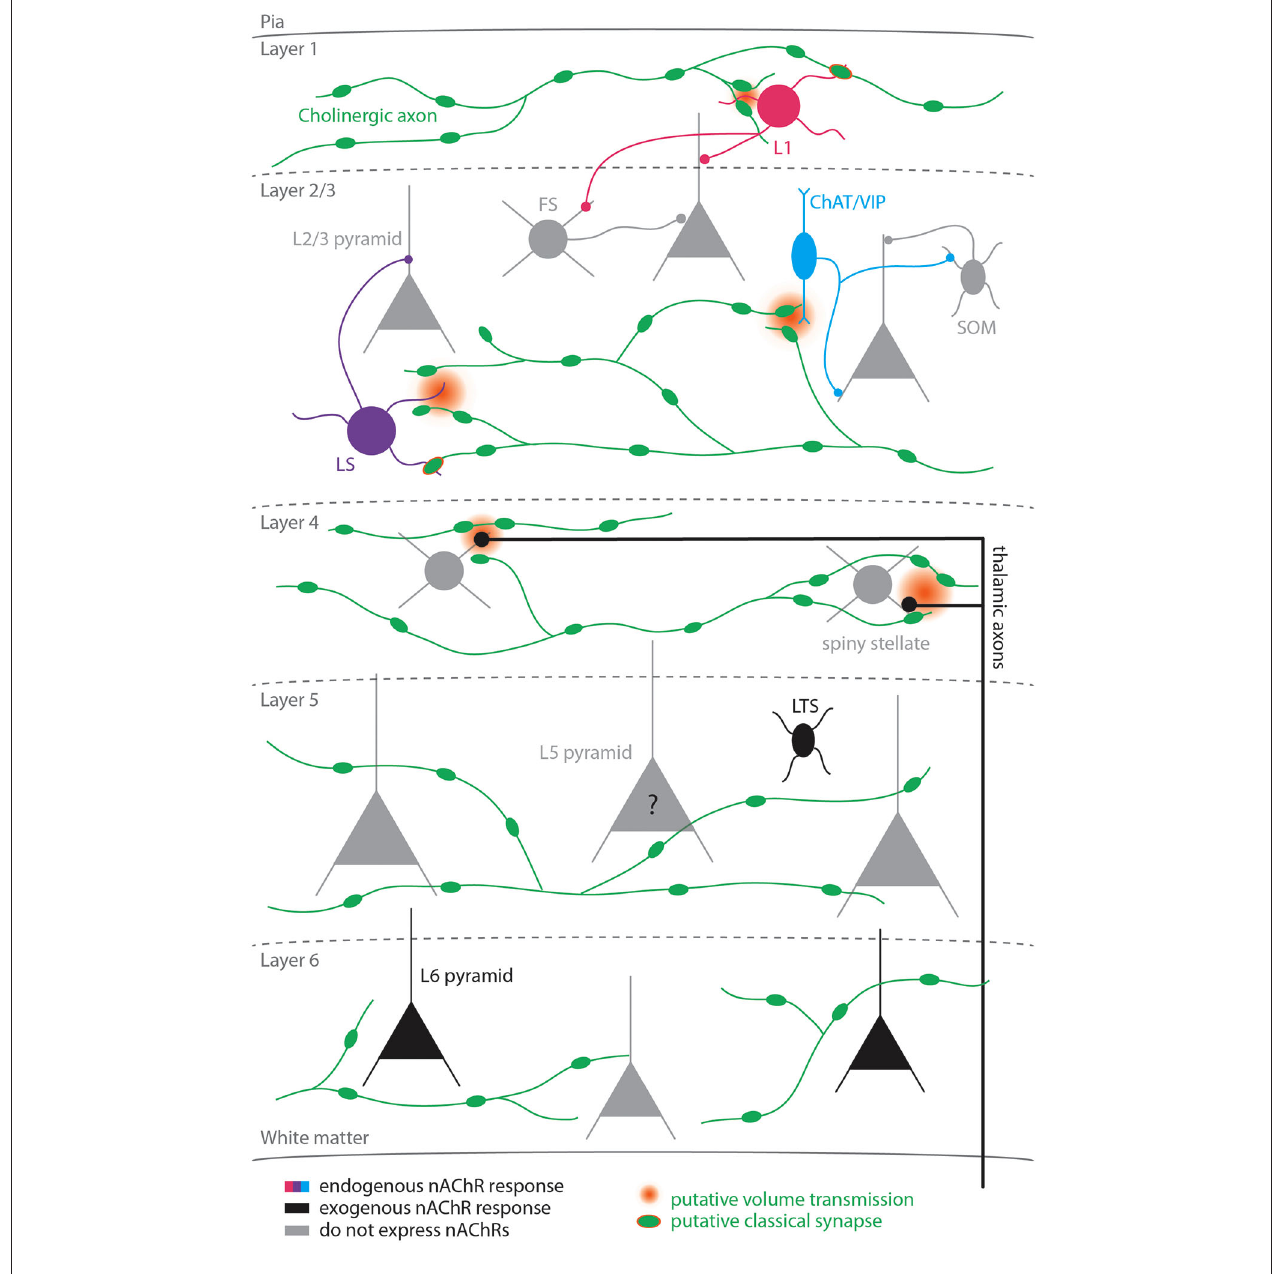
mark for L5 pyramidal cells reflects the fact that studies disagree as to whether this cell-type expresses functional nicotinic receptors. Two types of nicotinic signaling are depicted: putative volume transmission targeting non- α 7 nAChRs (gradient) and putative classical synapses targeting α 7 nAChRs (green symbol with orange